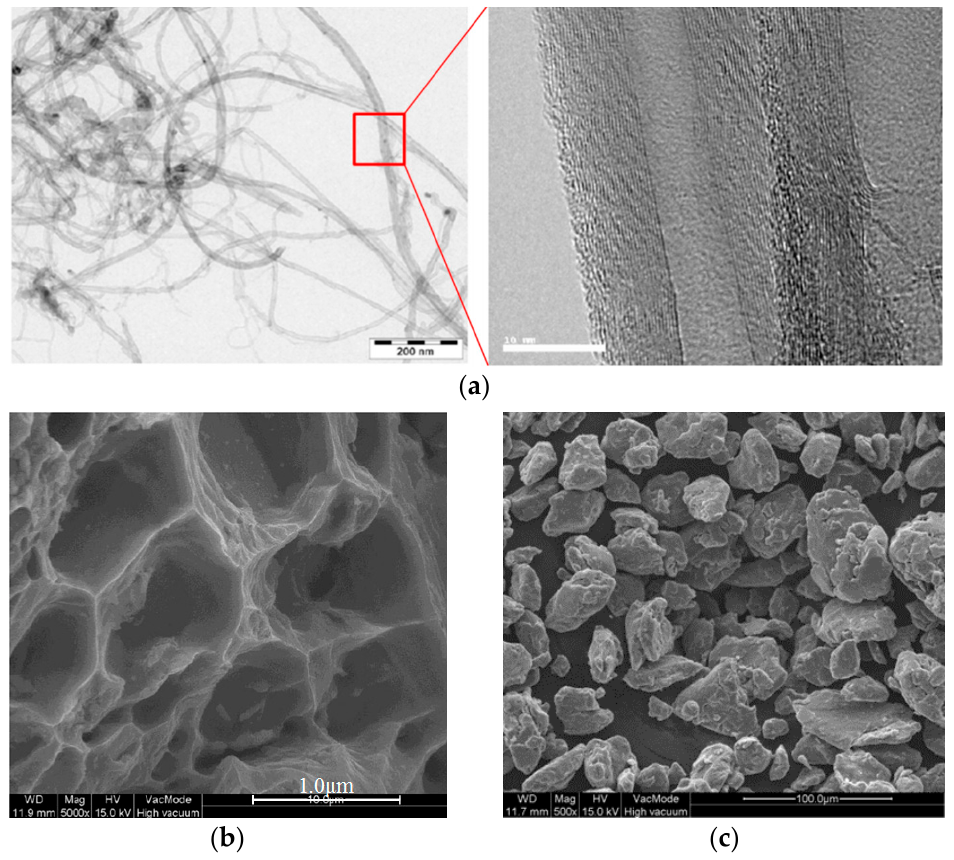
Figure 1. ( a ) Transmission electron microscopy (TEM) micrographs of pristine multi-walled carbon nanotubes (red square : 20 times magnification); ( b ) scanning electron microscopy (SEM) images of Al6061 and ( c ) SEM images of MWCNTs mixture powder. Table 1. Properties of multi-walled carbon nanotubes (MWCNTs) and Al6061 alloy. Material